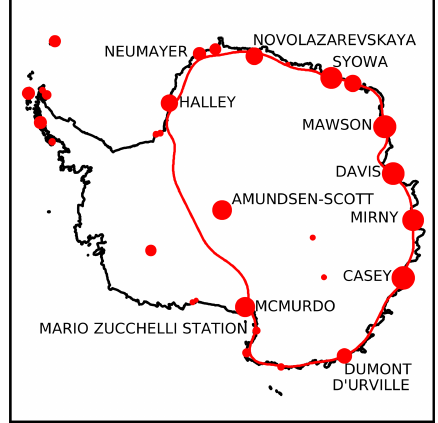
Figure 1. Location of the radiosonde launch sites and boundary of the East Antarctic ice sheet. The diameter of the dots is propor- tional to the number of archived soundings (maximum is Casey with 39000 soundings between 1957 and 2016). Only the sites selected for the study are